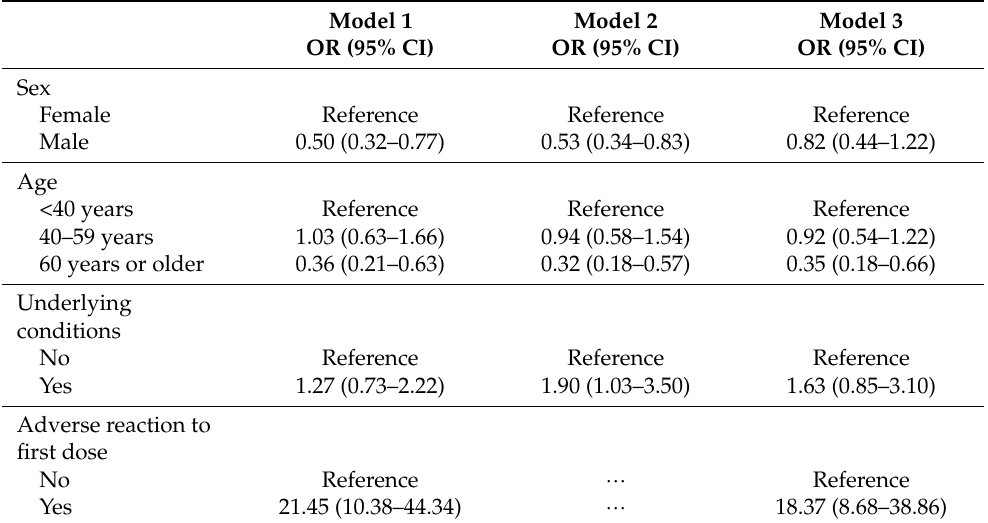
Table 3. Factors associated with local adverse reactions after the second dose of COVID-19 mRNA vaccine.